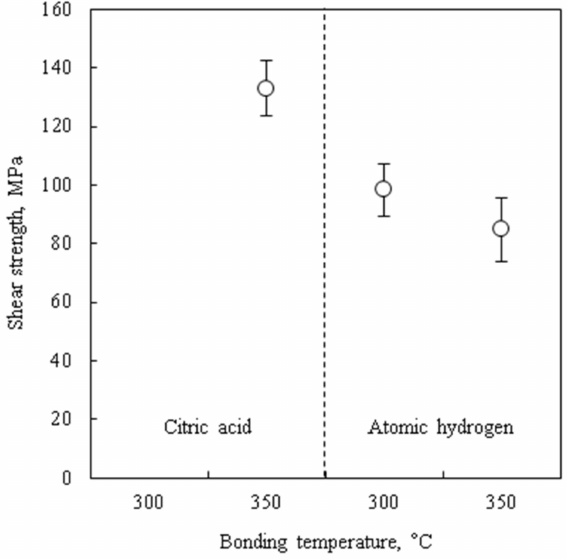
Figure 6. Shear strengths of the bonded